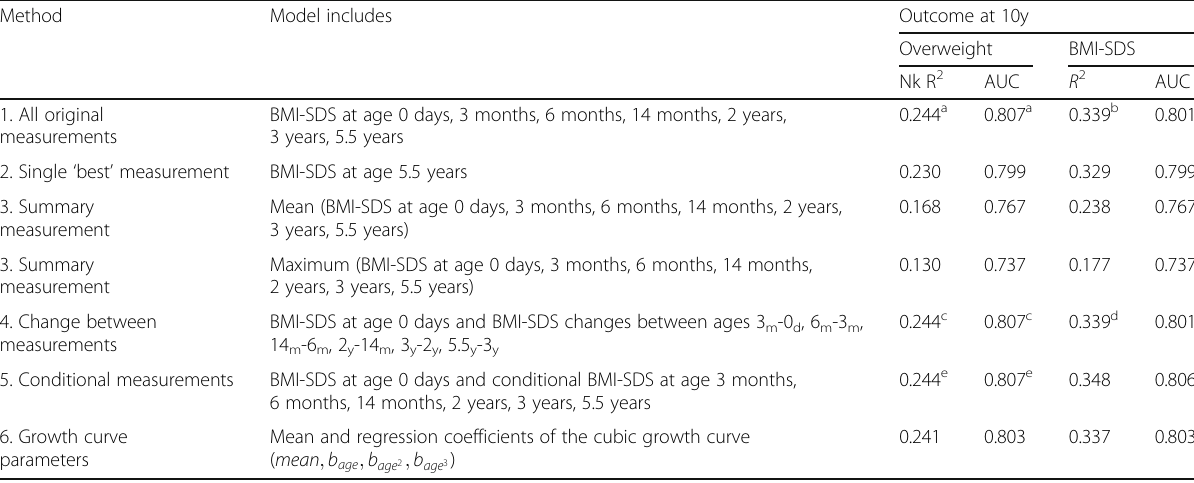
Table 2 The predictive quality of prediction models developed using different methods to include longitudinal predictor BMI-SDS Method Model